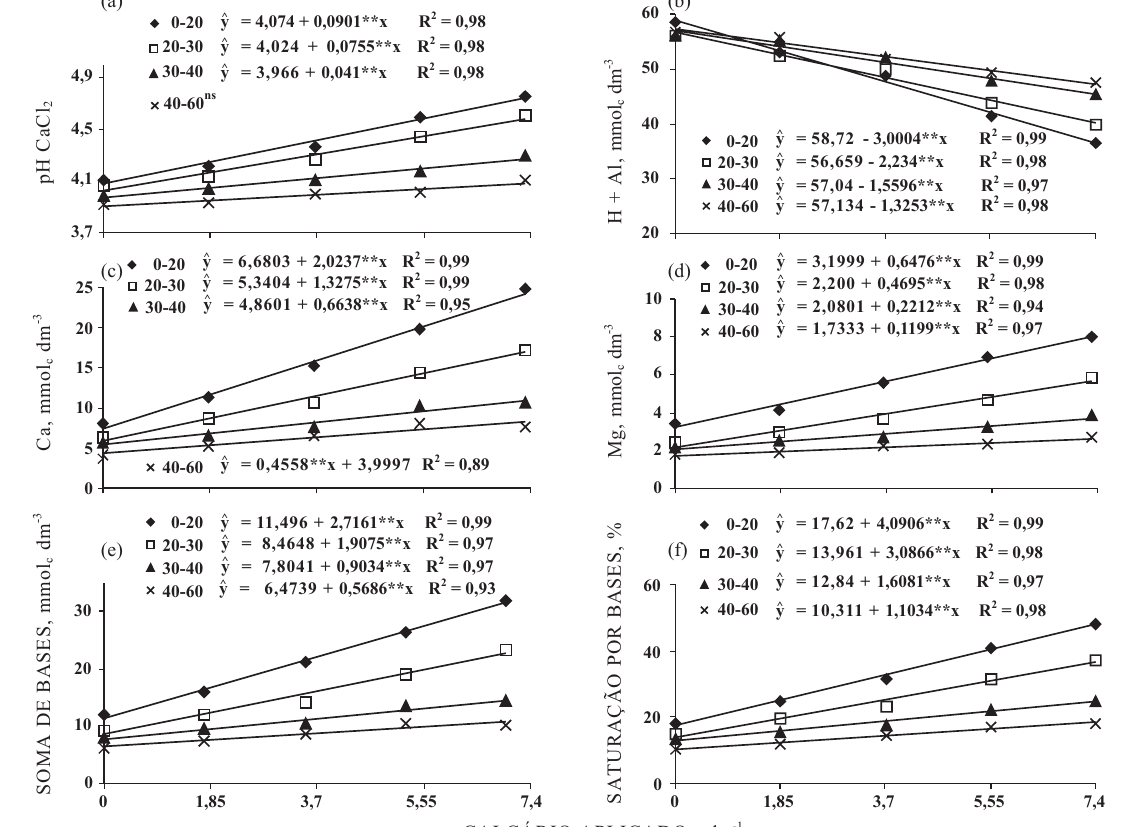
Figura 2. Efeito da aplicação de calcário no pH (a), H + Al (b), Ca (c), Mg (d), soma de bases (e) e saturação por bases (f), em diferentes profundidades do solo, em amostras da linha de plantio das goiabeiras. Os pontos são médias de 10 épocas de amostragem em cada uma das camadas de 0–20, 20–30 e 30–40 cm e nove épocas de amostragem na camada de 40–60 cm, e quatro repetições. ** Significativo p < 0,01 e * Significativo p <